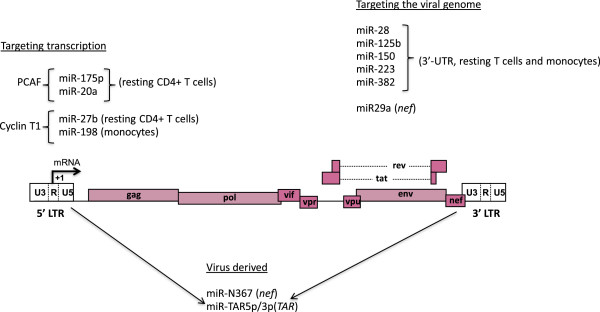
Modulation of HIV-1 replication by miRNA. HIV-1 impacts the cellular miRNA pathways in several ways. The figure shows a schematic representation of the HIV-1 provirus with the indicated viral genes and LTRs, including the transcription start site in the 3’LTR. PCAF and Cyclin T1, which are both essential cofactors for viral transcription, are targeted by the indicated miRNAs in resting T cells and monocytes. A cluster of miRNAs is targeted directly towards the 5'end of the HIV-1 genome and their inhibition rescues infectious virus from resting T cells. Finally two sets of miRNA that are derived from the HIV-1 genome are shown. Their location within the LTR (TAR and nef) is duplicated (arrows).